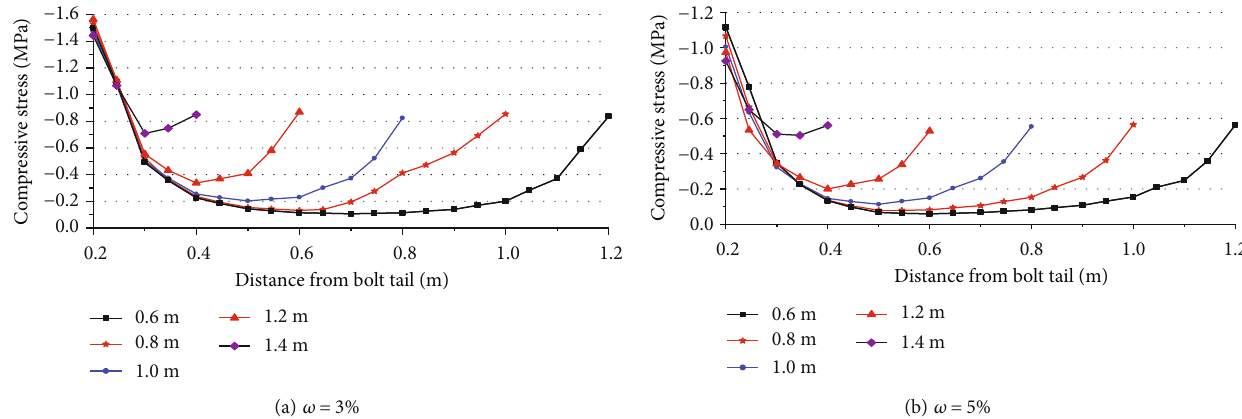
Figure 12: Distribution curve of axial direction compressive stress.